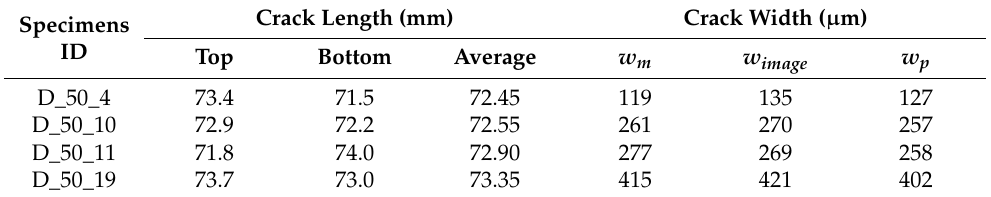
Table 3. Crack width recalculation considering the actual shape of the